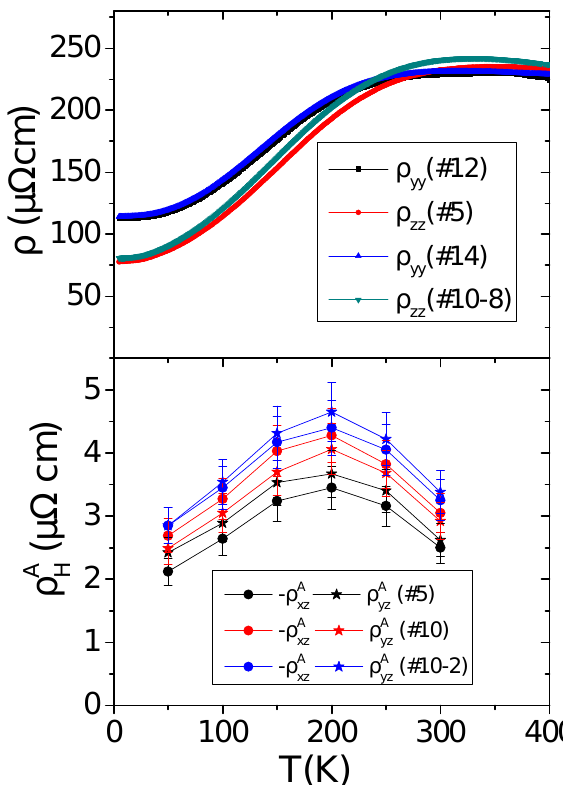
Figure S5: a) Temperature dependence of ρ and ρ measured in two different samples, respectively, show almost identical be- zz havior. b) The anomalous Hall resistivity on various samples at several temperatures.